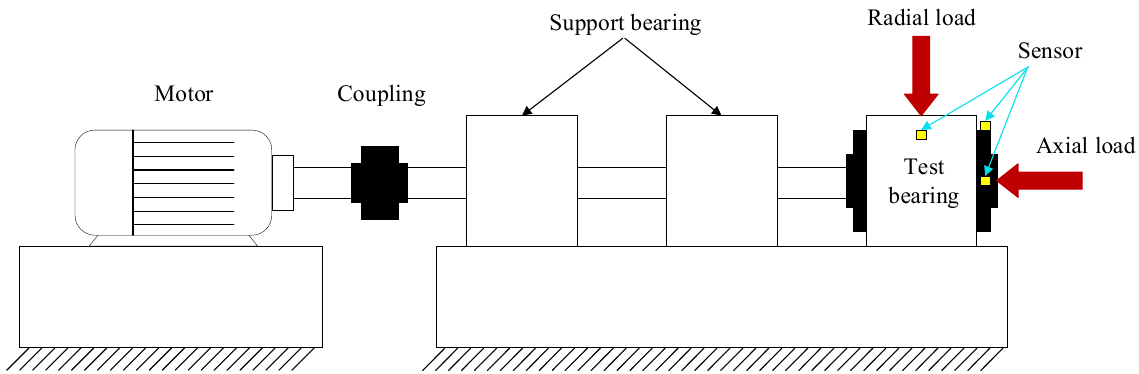
Figure 17. Schematic diagram of railway bearing comprehensive experimental bench.